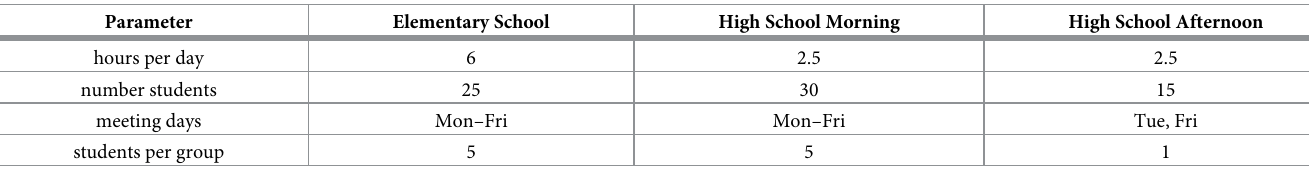
Table 2. Classroom